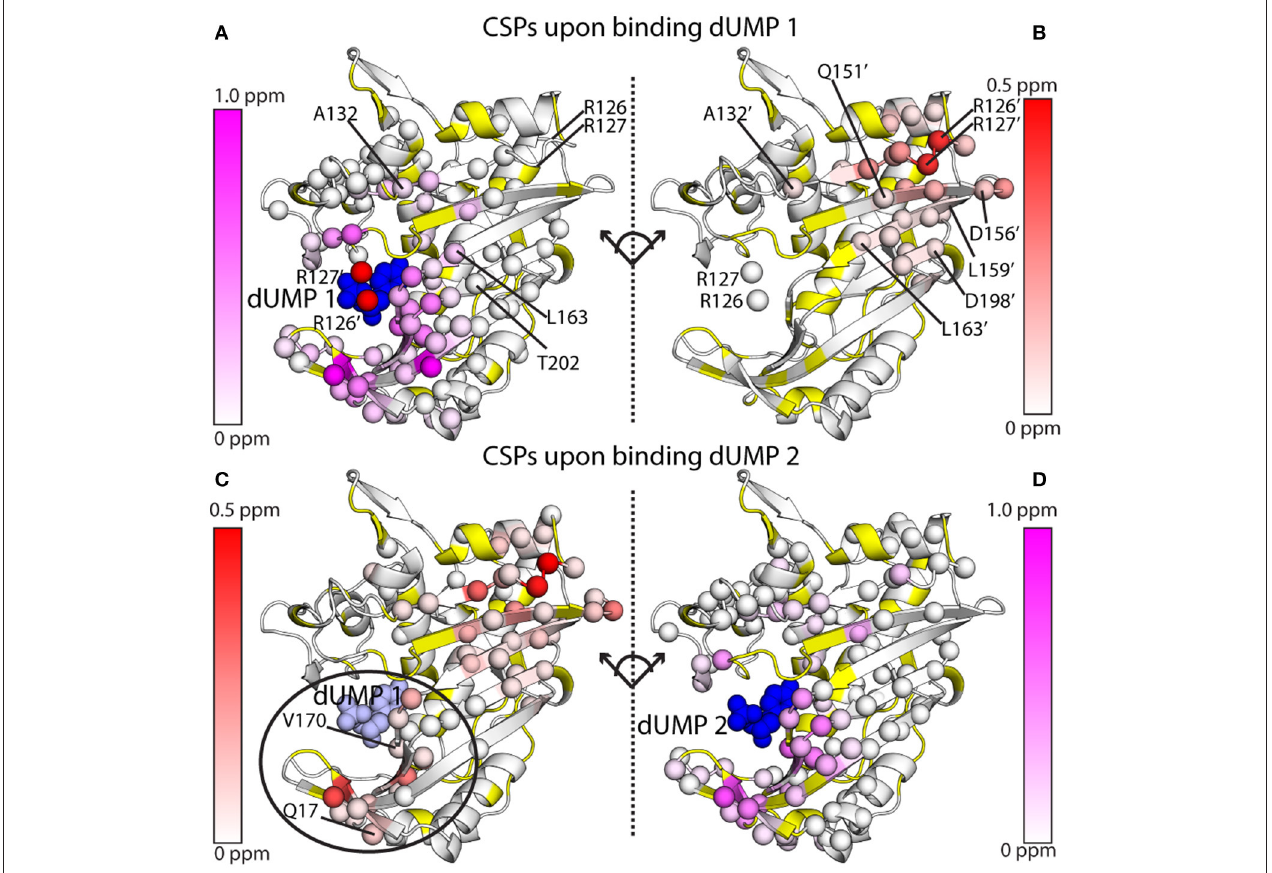
FIGURE 7 | 1 H- 15 N amide chemical shift perturbations (CSPs) for the two dUMP binding events for ecTS, obtained from MLD samples as shown in Figure 6 . (A,B) CSPs are shown for binding of the first dUMP (blue spheres). CSPs are shown for the binding subunit (A) and the empty subunit (B) , which are split apart and rotated to take on the same orientation for ease of comparison. Residues from the empty subunit are indicated by primes, and in panel A R126’ and R127’ from the empty subunit are shown as red spheres, showing how these two residues contact dUMP in the opposite binding site. CSP values are colored according to the scaling scheme shown in each panel. (C,D) CSPs are shown for binding of the second dUMP (blue spheres), with the first dUMP shown in light blue spheres. Data are taken from Falk et al. (2016), which also describes how the chemical shifts were corrected and reconstructed for the wild-type peaks to allow calculation of CSPs for the second